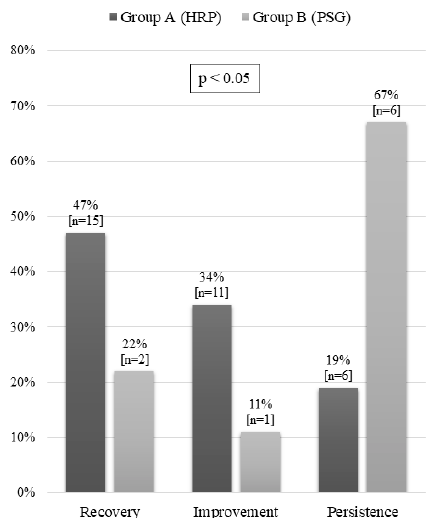
Figure 6. Progress after treatment by group. HRP: home respiratory polygraphy; PSG: polysomnography.